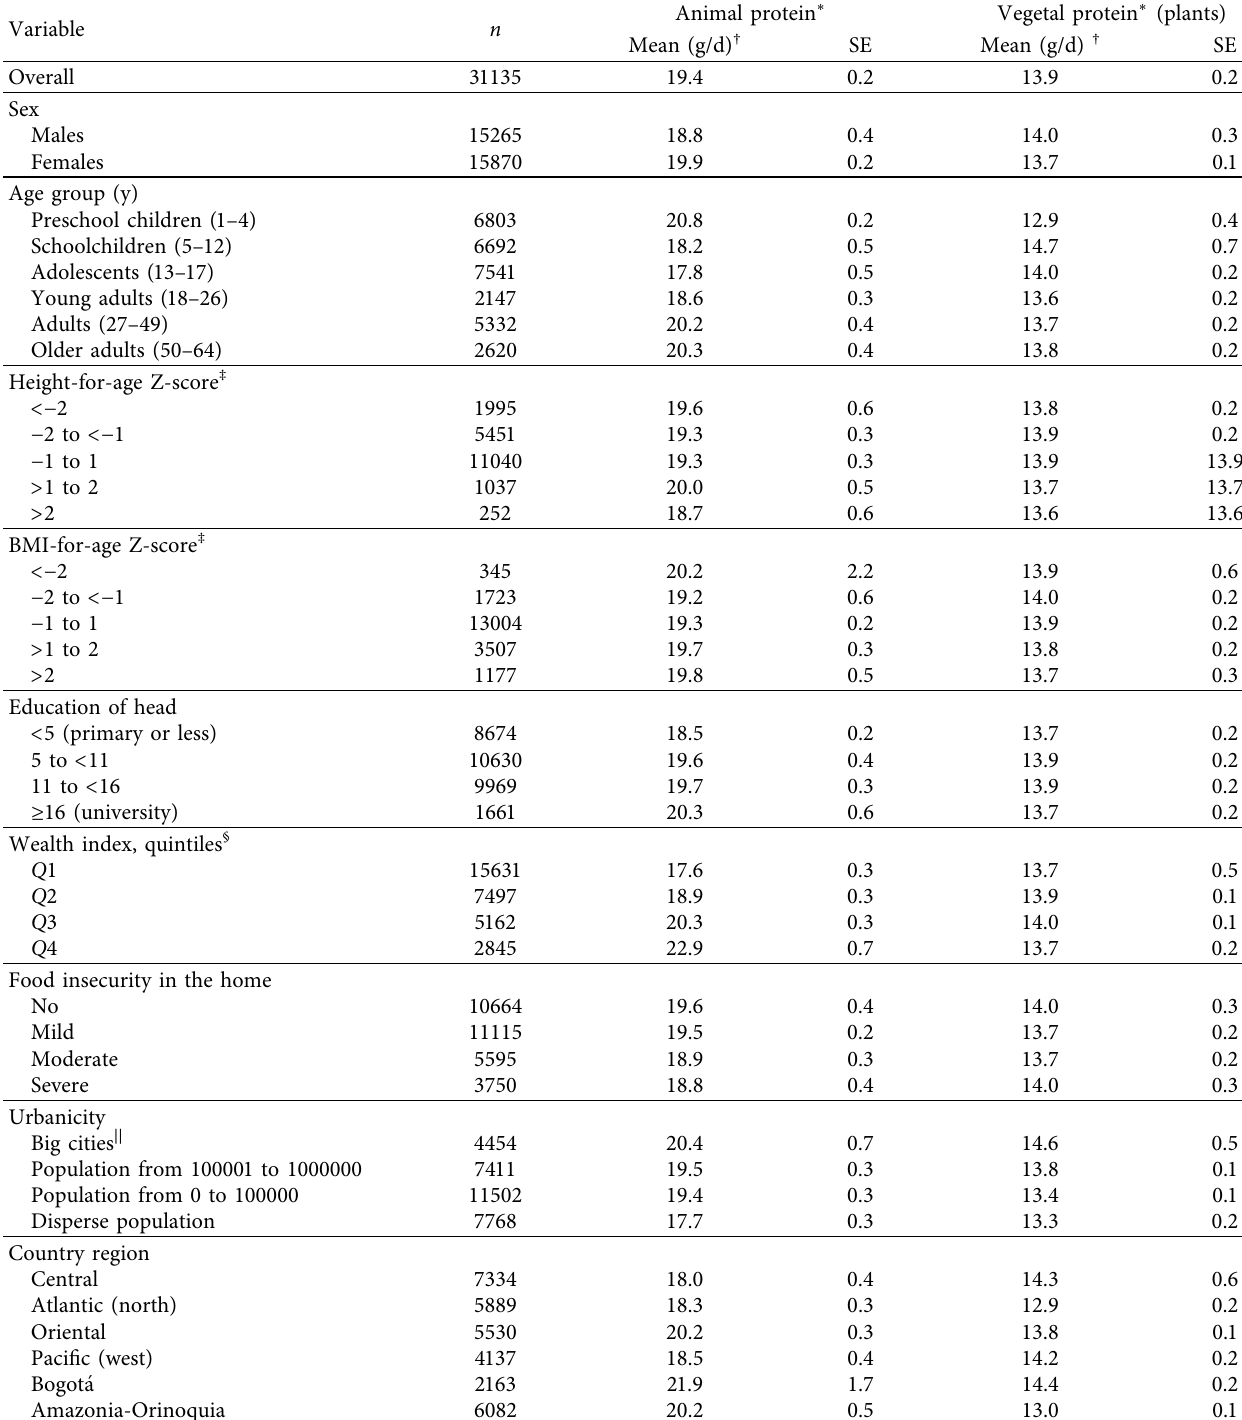
Table 1: Sociodemographic characteristics of the Colombian population (aged from 1 to 64 years, nonpregnant women) with estimates of the consumption of animal and vegetable protein, g/d for every 1000kcal consumed (National Survey of Nutritional Situation in Colombia